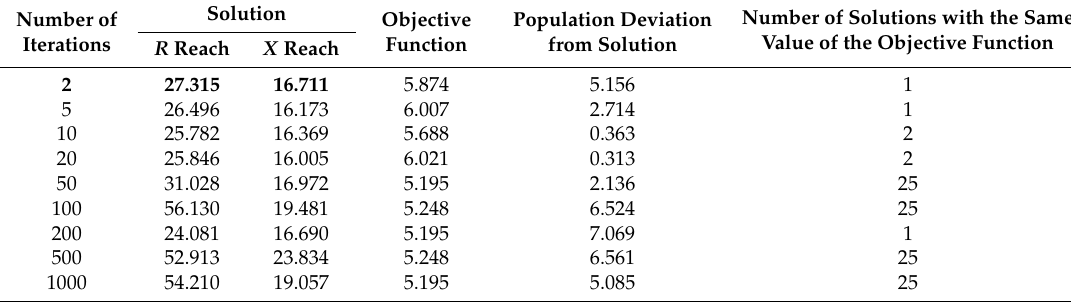
Table 5. Performance tests of the GA with a preference factor k = 0.8 and a mutation rate of 0.05. Solution Objective Number of Population Deviation Iterations Function from Solution